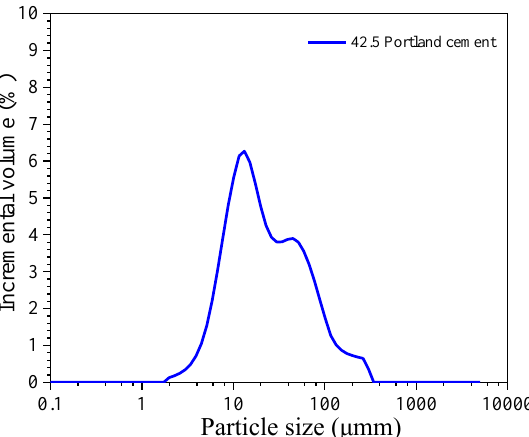
Table 6. Chemical compositions of the steel reinforcement in this study (wt. %).